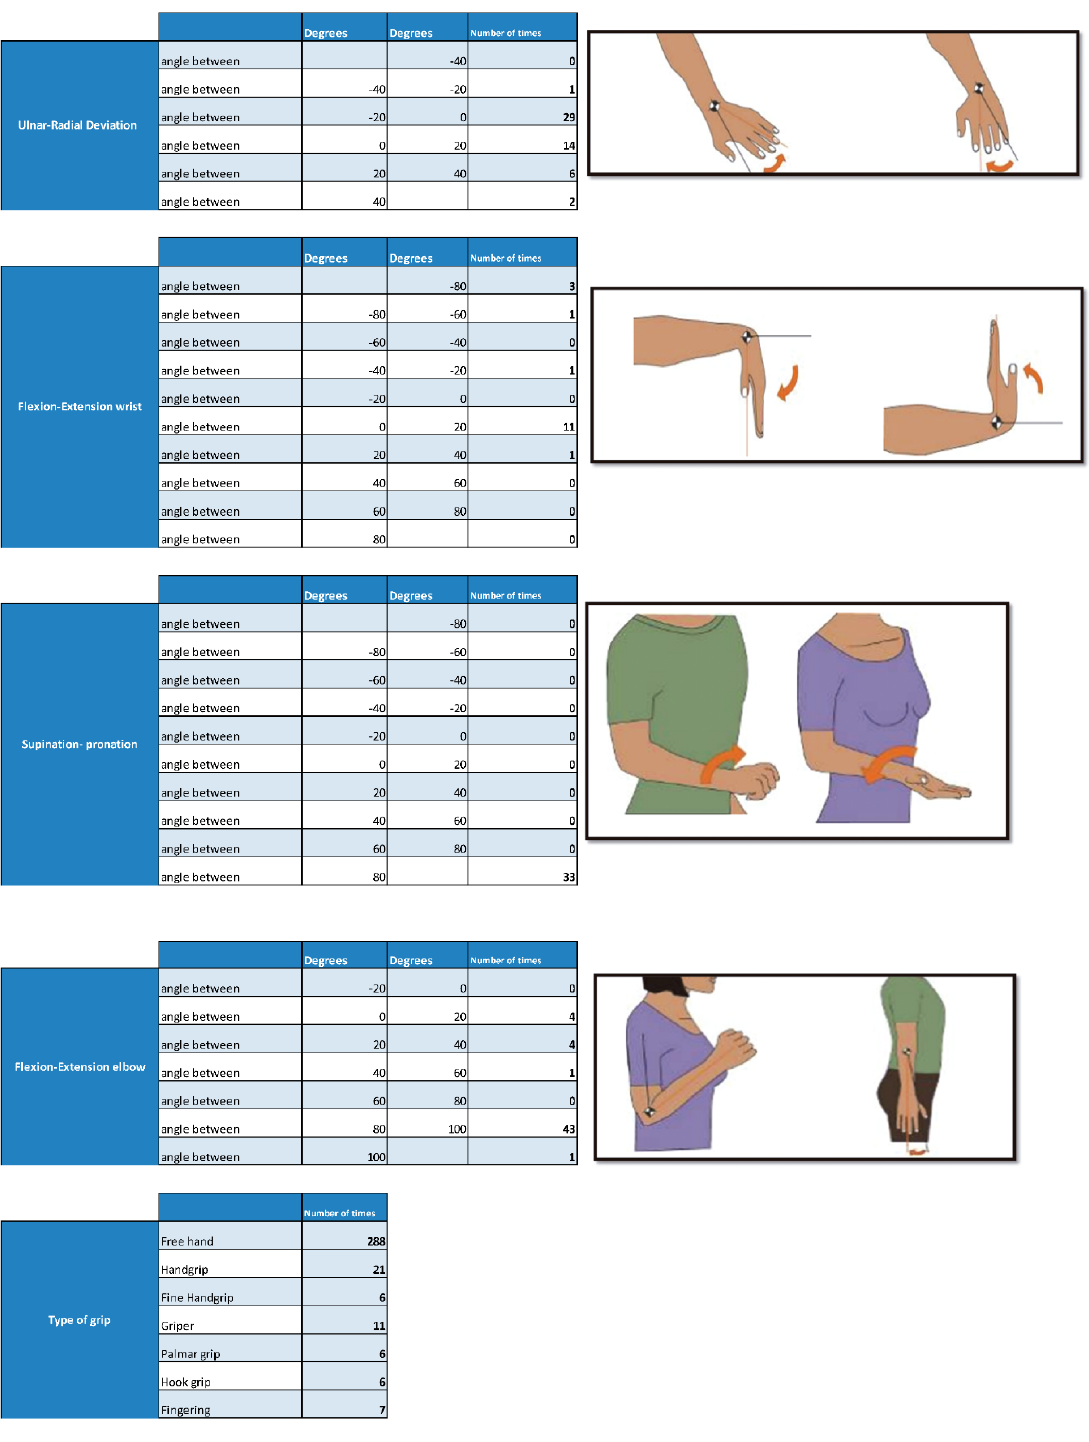
Figure 12. Analysis of angles formed in the wrist, elbow and types of grip.